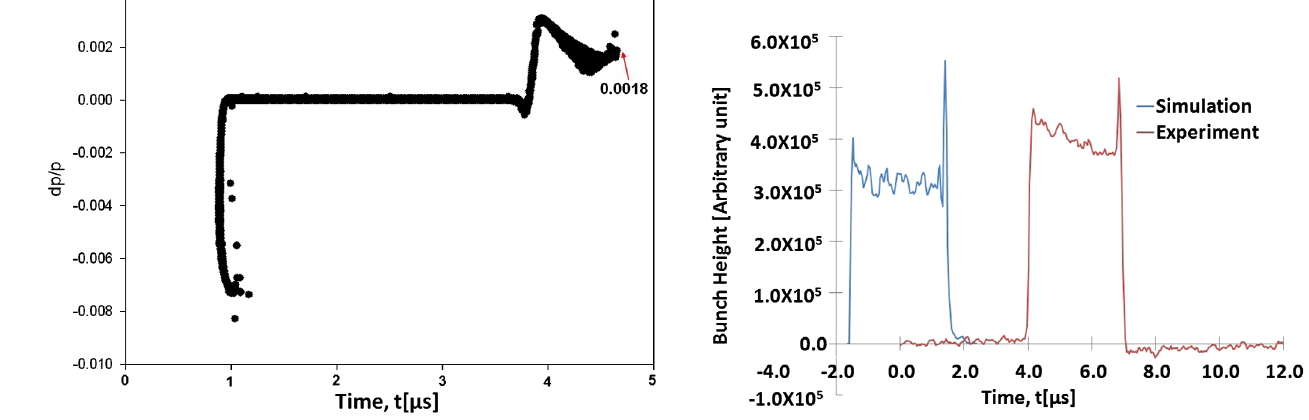
FIG. 30. Comparison of experimental and simulated bunch signals for the first turn in the